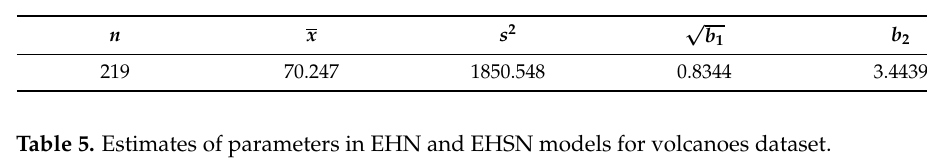
Table 4. Descriptive summaries for volcano heights (in 100 × feet).